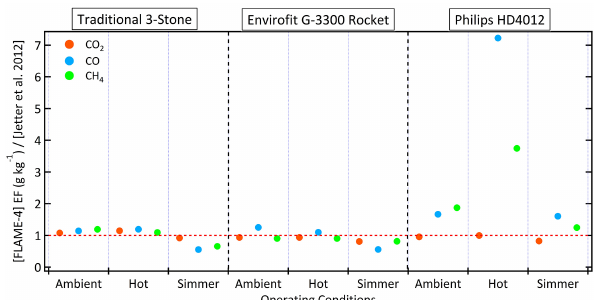
Figure 8. Comparison of FLAME-4 three-stone, Envirofit G-3300 Rocket, and Philips HD4012 cookstove EFs to EFs reported during performance testing by Jetter et al. (2012). The EzyStove was not tested by Jetter et al. (2012). Each circle represents the FLAME- 4 fire-average EF of all fuel types measured with all components starting at ambient temperatures compared to the Jetter et al. (2012) data collected under regulated operating